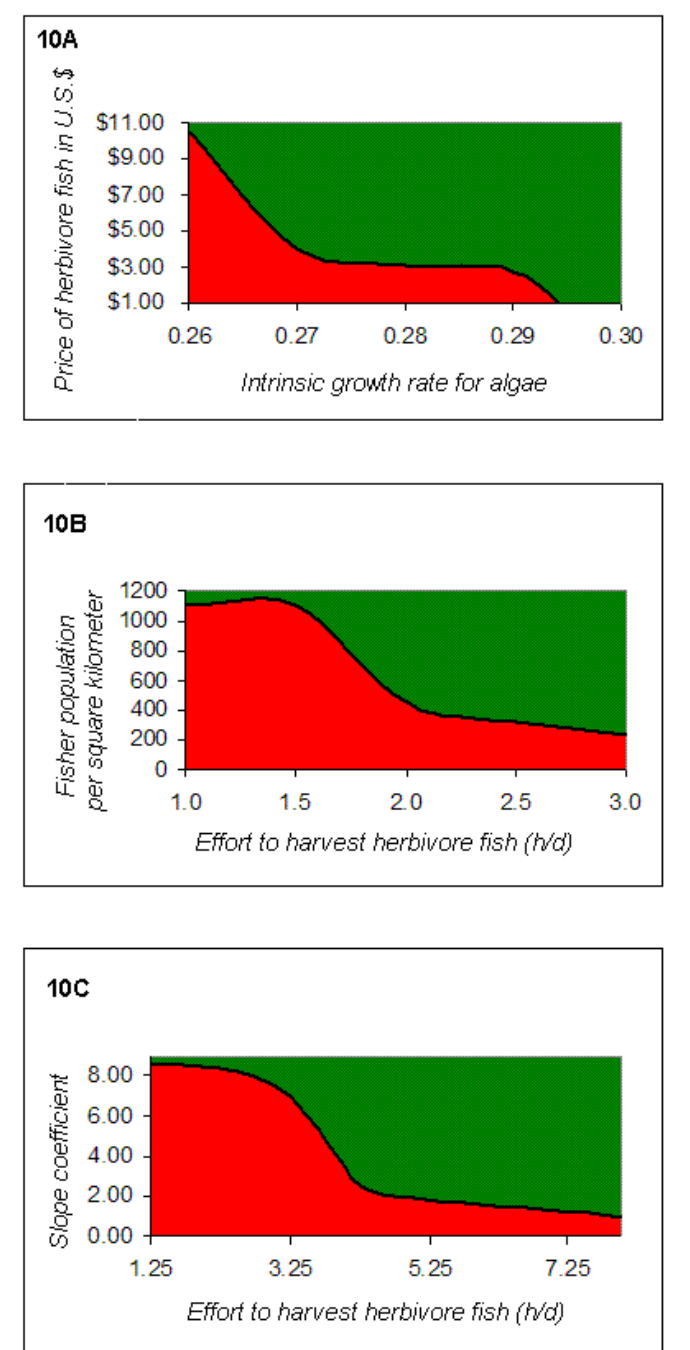
Fig. 10 . Graphical mapping of resilience thresholds resulting from variations in two parameters. Red, i.e. bottom, indicates coral-dominated stable state. Green, i.e. top, indicates algae-dominated stable